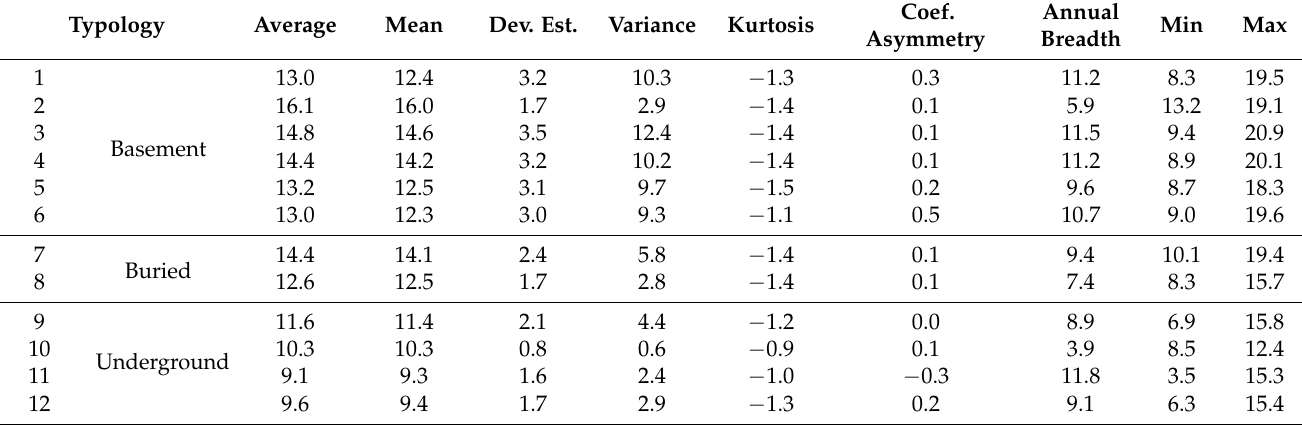
Table 1. Representative values of the internal temperature in each of the monitored aging